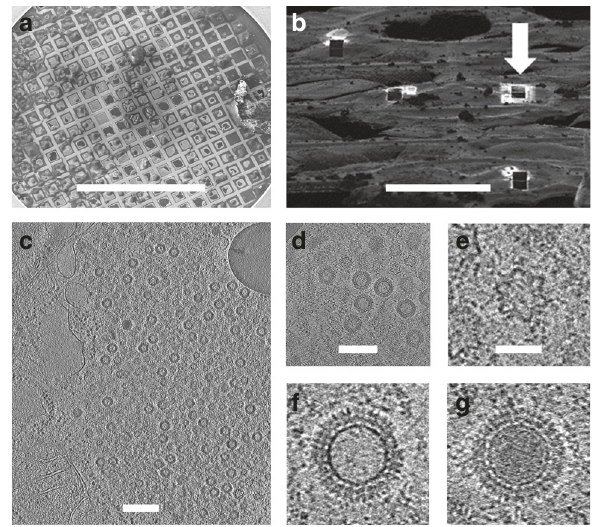
Fig. 1 FIB milling and tomograms. a SEM image of vitri fi ed infected cells on EM grid prior to FIB milling. Scale bar 1 mm. b SEM image after FIB milling. White arrow shows one of the four-milled lamellae. Scale bar 100 μ